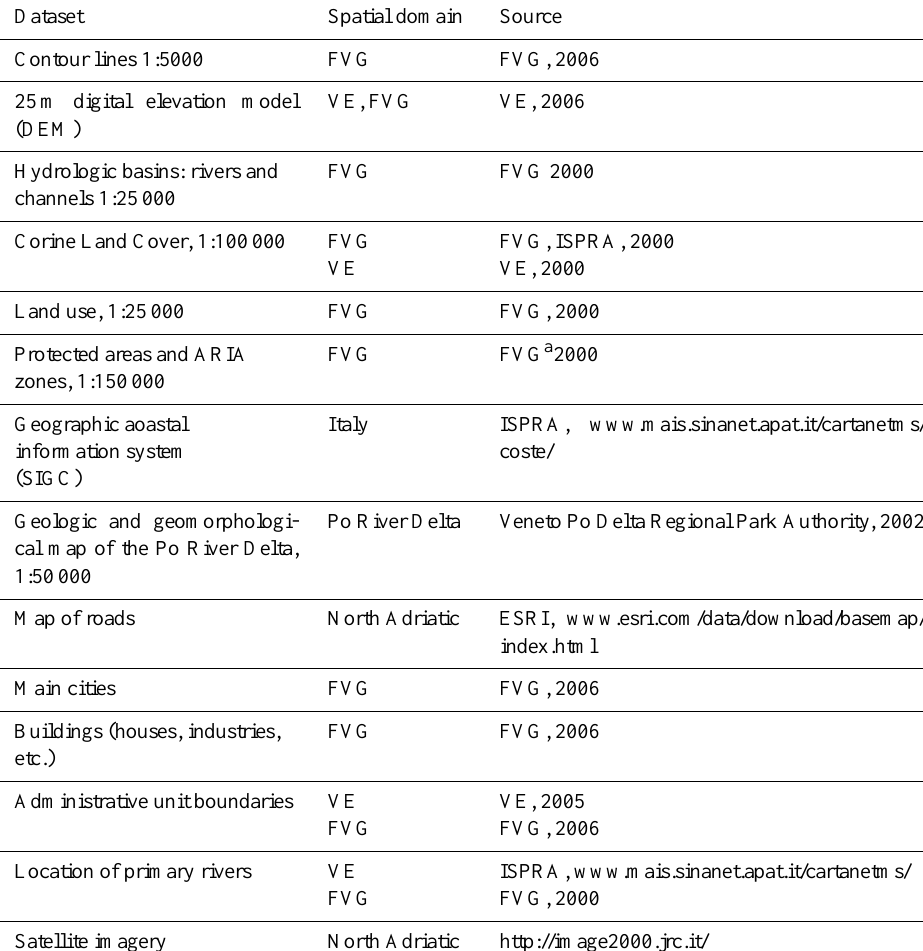
Table 4. Datasets used for the application of the regional vulnerability assessment methodology to the case study area (i.e. the North Adriatic coasts). FVG = Friuli Venezia Giulia region, Italy. VE = Veneto region, Italy. ISPRA = High Institute for Environmental Protection and Research, Italy. ESRI = Environmental Systems Research